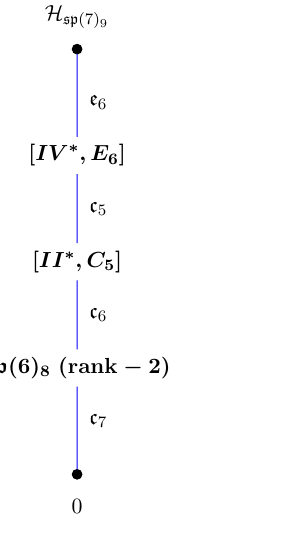
Figure 23. The Hasse diagram for the Higgs branch of the sp (7) 9